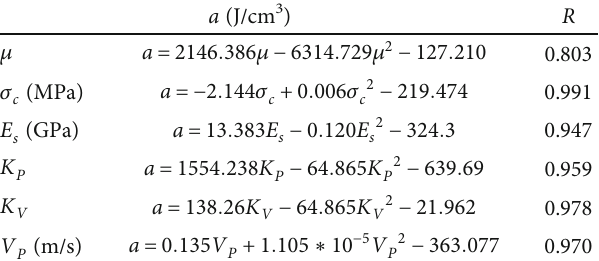
Table 3: Results of granite physical mechanical parameters and chiseling speci fi c energy fi